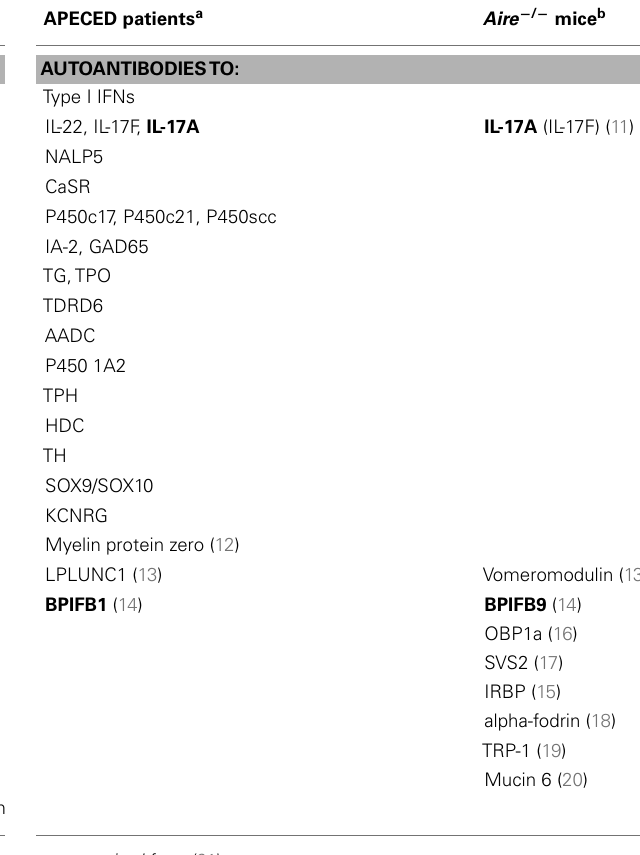
Table 1 | Phenotypes and autoantibodies differ betweenAPECED patients and Aire − / − mice